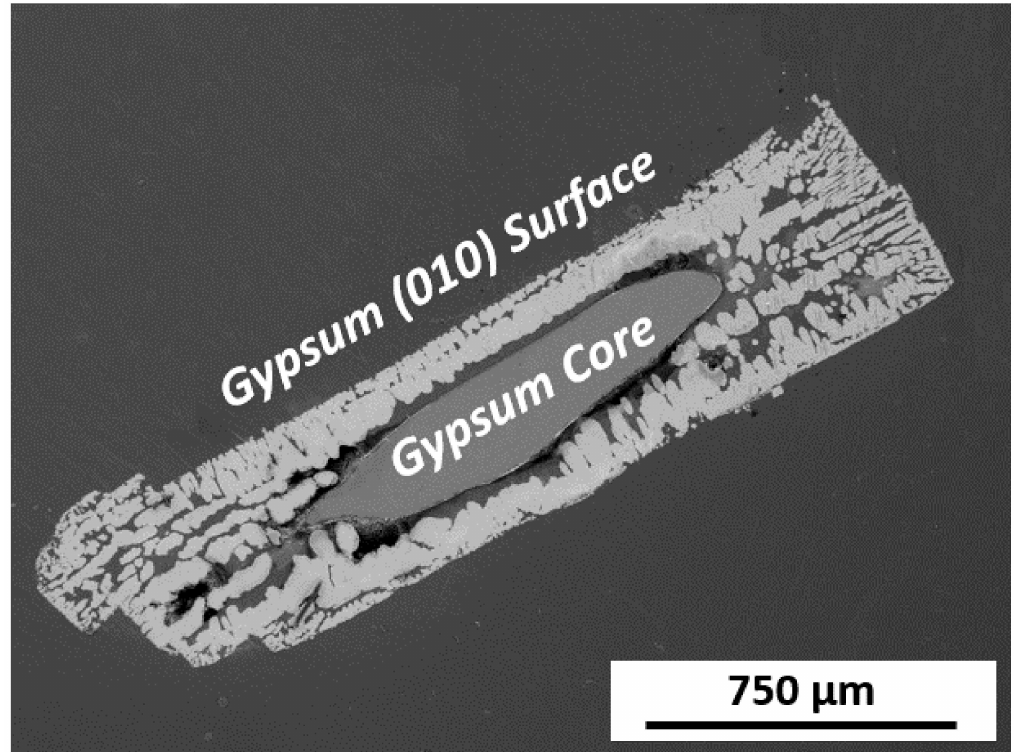
Figure 4. BSE image of a cross-section perpendicular to the (010) surface of gypsum after 3 h interaction with a 0.5 M Sr-bearing aqueous solution. The width of the celestite secondary layer is not homogeneous. Those regions of the celestite layer that are perpendicular to the gypsum (010) surface reach smaller widths than those perpendicular to surfaces that belong to the [010]